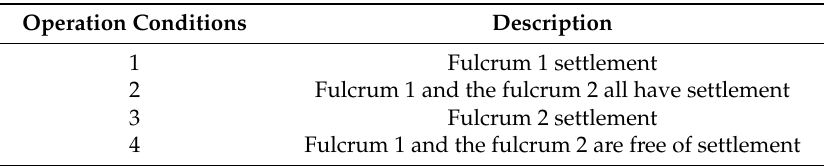
Figure 24. Horizontal and vertical amplitudes of four settlement conditions.